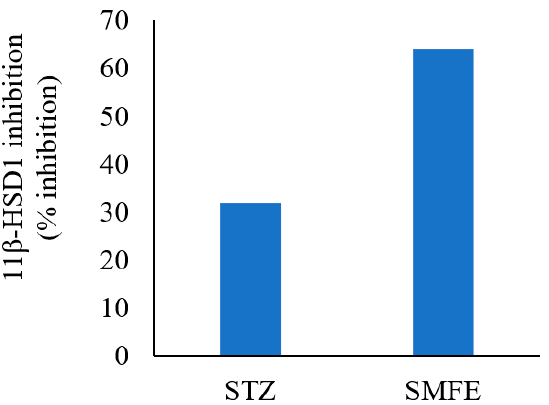
Figure 5. Effect of SMFE activity on 11 β -HSD1 dehydrogenase activity ( n = 3), p < 0.05.